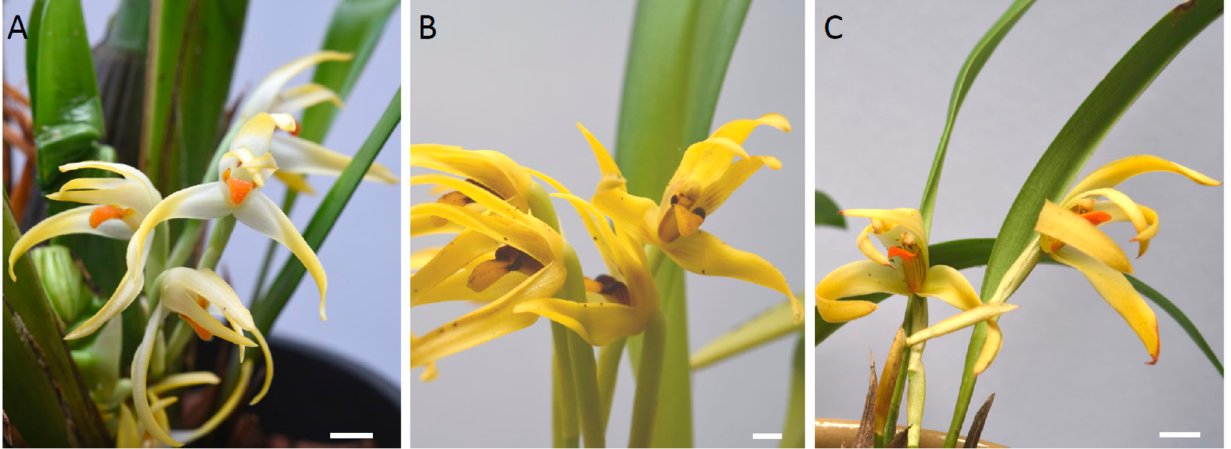
Figure 1. ( A – C ). Floral gross morphology of: ( A ). Maxillaria ochroleuca ; ( B ). Maxillaria pauciflora ; ( C ). Maxillaria weberbaueri . Scale bars = 5 mm.